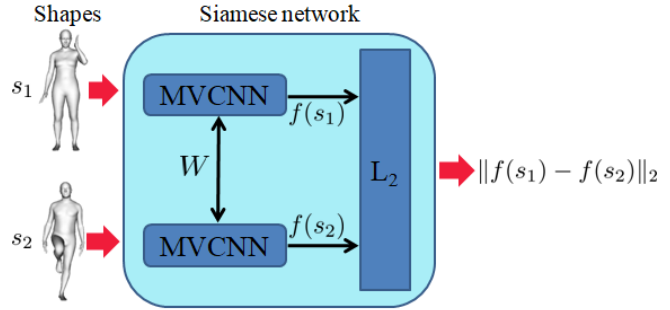
Figure 4. Architecture of the Siamese network, where pairs of 3D human shapes are processed by two copies of the same MVCNN sharing the learned parameters W